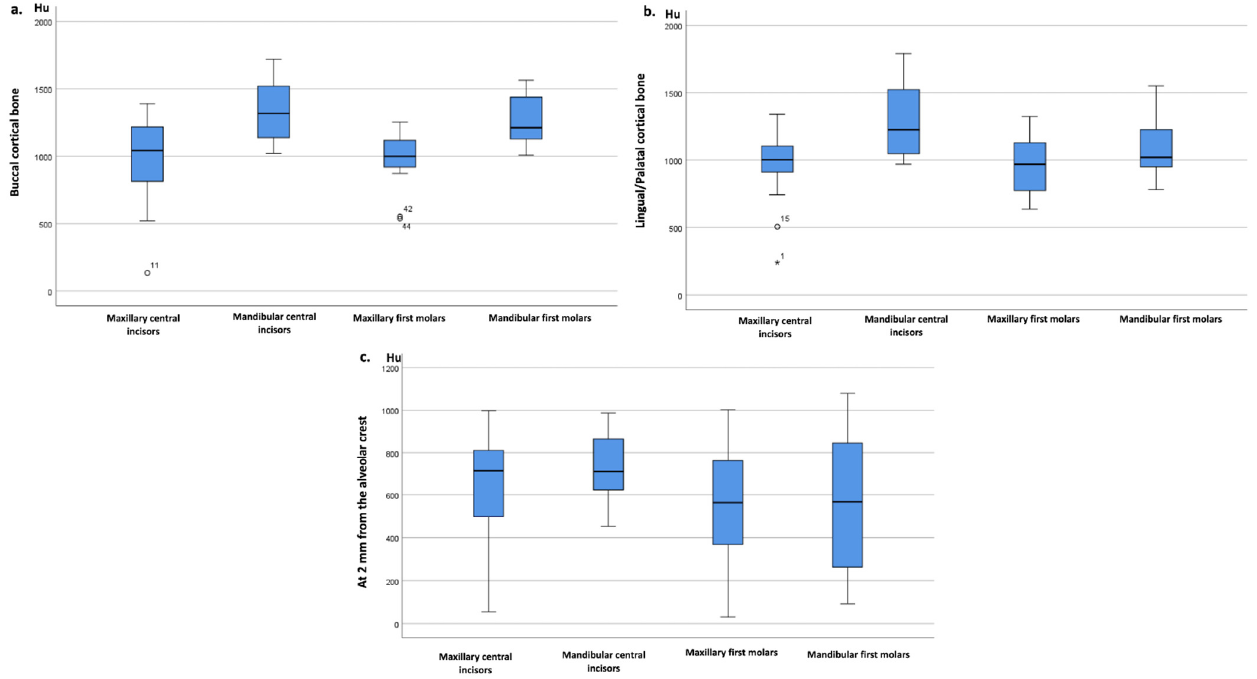
Figure 1. Box plot distribution of HU (median, IQR, maximum, minimum) in the three areas of interest; ( a ) Buccal cortical bone; ( b ) Lingual/Palatal cortical bone; ( c ) At 2 mm from the alveolar crest in the trabecular bone (for each area of interest a number of eighty measurements were in ‐ cluded, corresponding to twenty cases in each of the following sites: maxillary central incisors, man ‐ dibular central incisors, maxillary first molars, and mandibular first molars). In both maxillary and mandibular alveolar crests, HU were slightly higher for inci ‐ sors compared to molars, but no significant differences could be proven, except for the lingual cortical bone of mandibular central incisors vs. mandibular first molars ( p = 0.013; Mann Whitney test). Buccal vs. lingual or palatal cortical HU values did not differ signif ‐ icantly. 3. Discussion The bone represents a very active tissue that is constantly changing. Bone density differs depending on the jaw topographic area. The bone with the highest density is usu ‐ ally found in the anterior mandible, while the least dense bone is located in the posterior maxillary. Bone density is essential in choosing the type of implant, and it decreases with age. Investigating the bone density of prospective dental implant sites is crucial both for choosing the implant type and for choosing the drilling procedure best suited to ensure implant stability and osseointegration [24]. The aim of this study was achieved by testing the hypotheses of there being no sig ‐ nificant differences between the bone densities in the alveolar crest areas of maxillary and mandibular central incisors, as well as between those corresponding to maxillary and mandibular first molars. As discussed above, in a retrospective study of CT images, Krikos and Misch estab ‐ lished correlations between bone density categories and HU, with D1 having the highest value, at >1250 HU, followed by D2, with values ranging from 850 to 1250 HU, and D3, from 350 to 850 HU; D4 and D5 had the lowest bone density values, at 150 to 350 HU and <150 HU, respectively. Additionally, it was observed that D1 bone was predominantly present in the anterior mandible, followed by D2 and D3 bone quality in the anterior max ‐ illary and posterior mandible. D4 bone quality was primarily observed in the posterior maxillary [26].